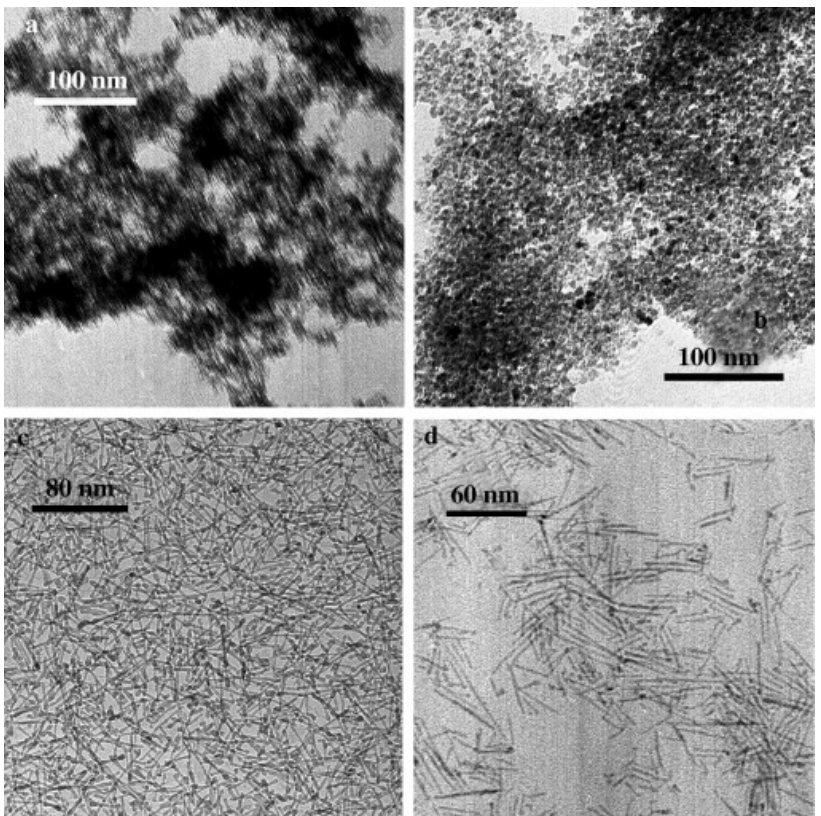
Figure 5. TEM images of TiO 2 synthesized from different LA amounts: ( a ) 0, ( b ) 2, ( c ) 7 and ( d ) 25 mL. Reproduced from reference [25] with permission of Wiley Online Library.